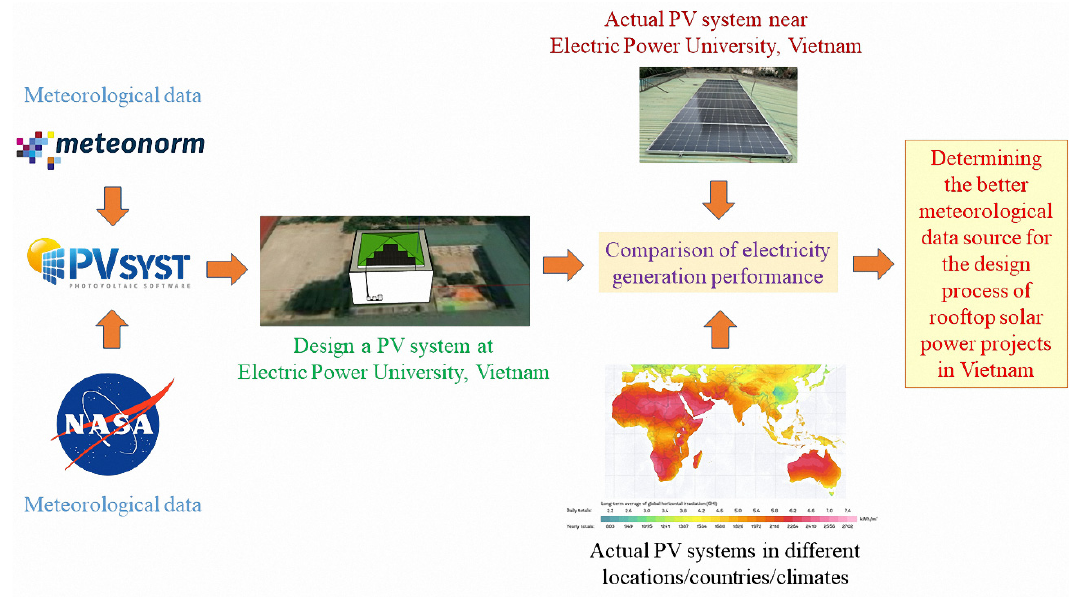
Figure 1. Graphical abstract of the research.